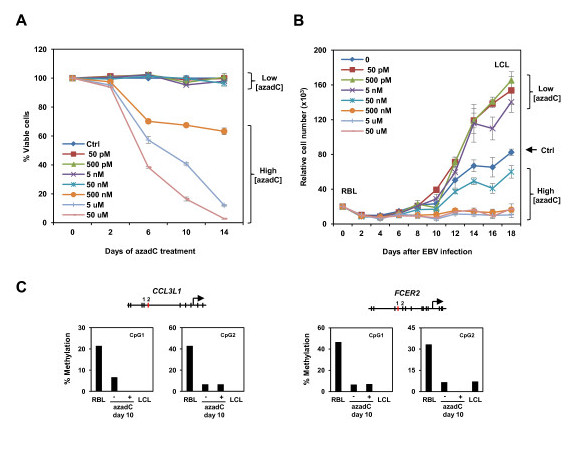
Effects of 5azadC in RBL to LCL conversion. (a) Influence of 5azadC treatments in viability of LCLs determined by flow cytometry based on propidium ioidide fluorescence. (b) Influence of 5azadC treatments in proliferation, as determined by MTT assays, during RBL to LCL conversion. (c) Bisulfite sequencing of two example genes, where methylation levels of two CpG sites is shown (the one represented in the array is highlighted in red). Methylation analysis was done in RBL cells at 10 days after EBV infection in the absence and presence of azadC, and in LCLs.